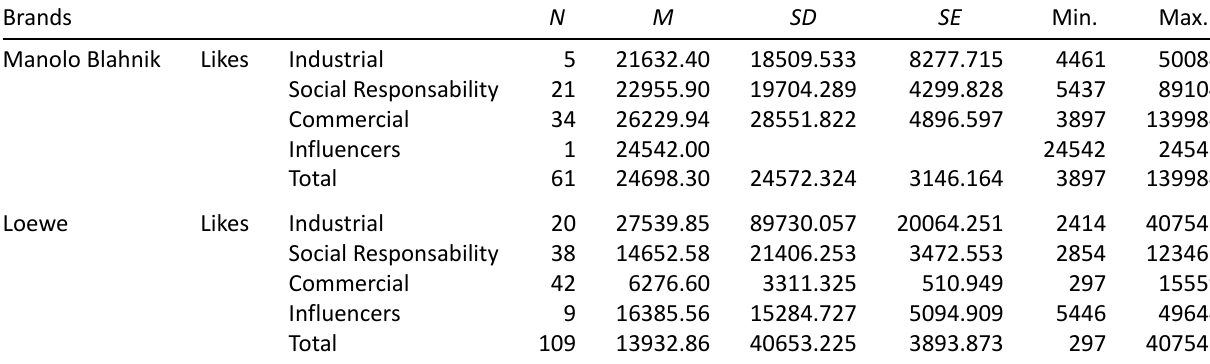
Table 2. Descriptive statistics of the sentiments “likes” generated as a function of brand content.